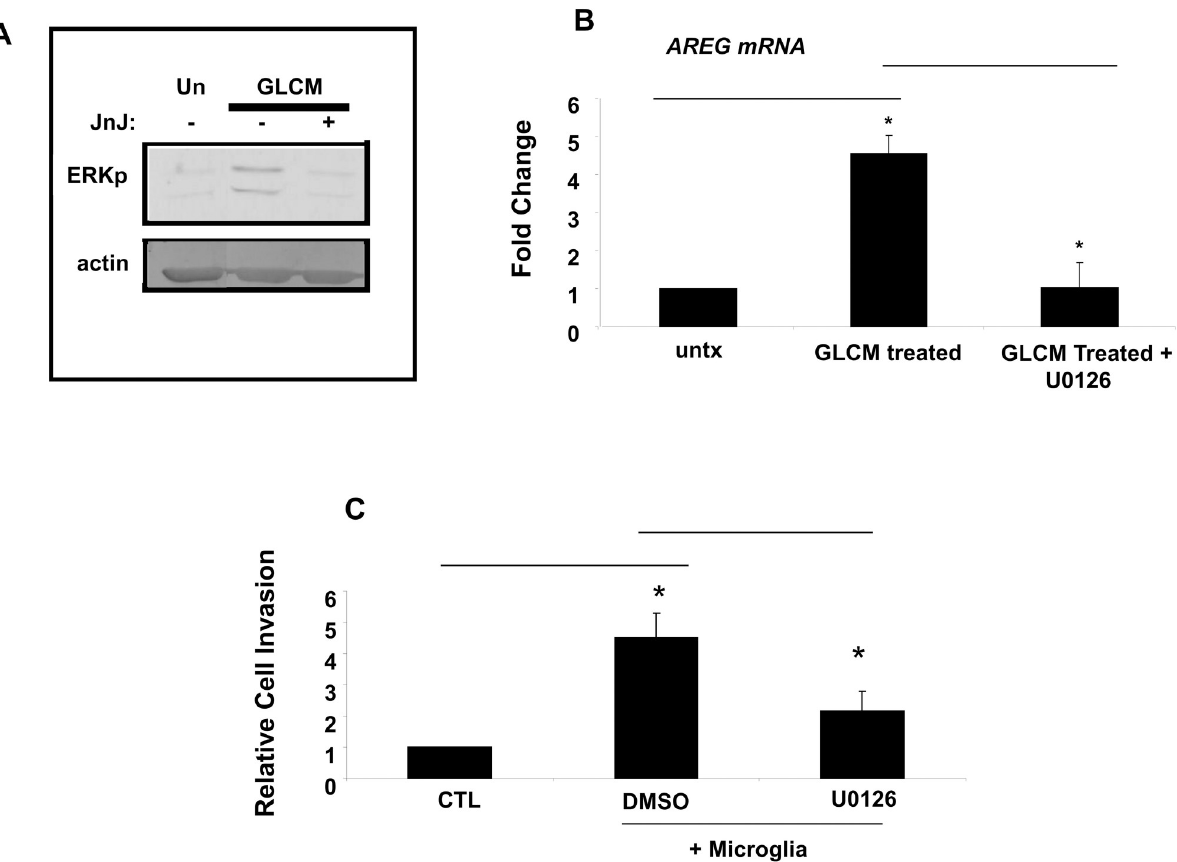
Fig 5. Role of MEK/ERK in CSF1R dependent AREG induction and invasion. (A) Microglia cells were stimulated with GL261 conditioned media in the absence or presence of the CSF1R inhibitor JnJ and analyzed by SDS-PAGE for phospho-ERK levels. (B) AREG expression in GL261-stimulated microglia was analyzed by qRTPCR in the presence of the MEK inhibitor U0126. (C) GL261 cells expressing mCherry were cocultured with microglia on Matrigel-coated invasion chambers in the absence or presence of the MEK inhibitor U0126. � :P < 0.05.